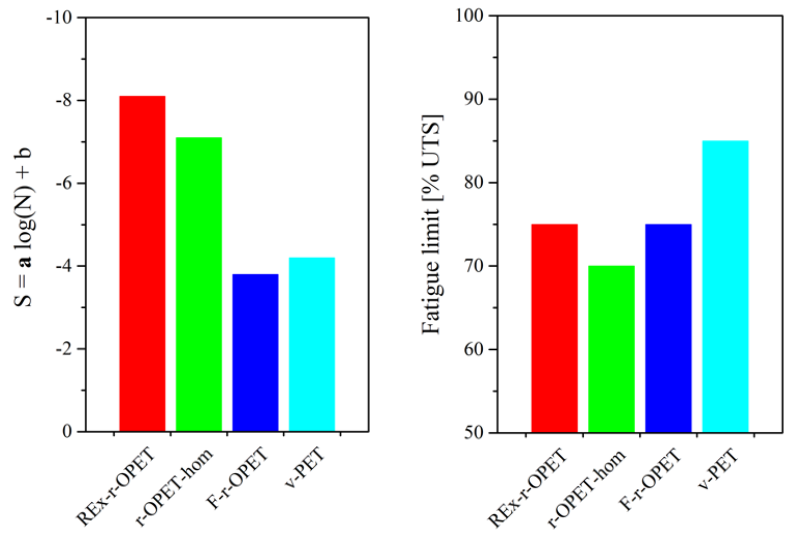
Figure 9. Fatigue life parameter a represents the kinetics of damage apparition ( left ) and fatigue limit